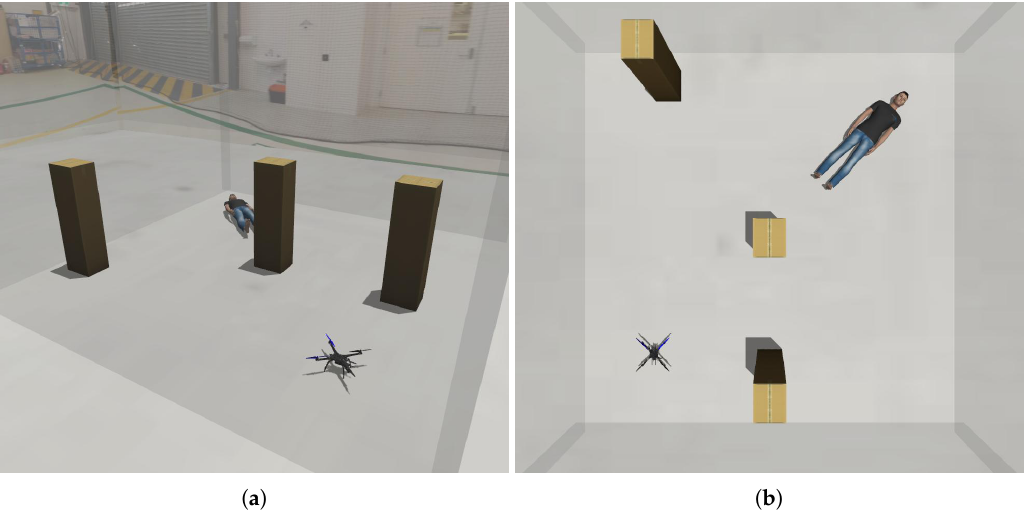
Figure 7. Environment setup for autonomous UAV victim finding in HIL simulations and real-flight tests. The victim is static and is always located at the opposite end from the take-off position of the UAV. ( a ) Isometric view of the environment simulated in Gazebo. ( b ) Top view of the environment simulated in Gazebo.